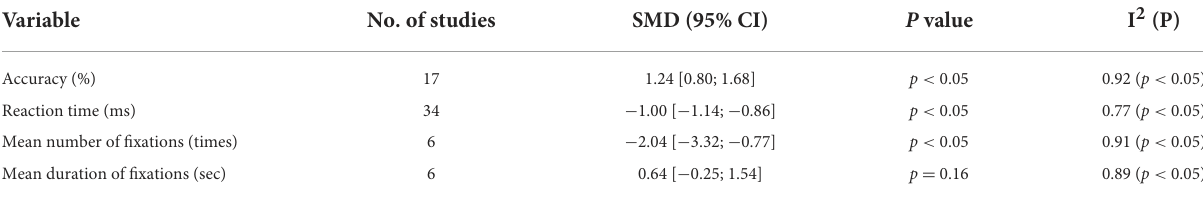
TABLE 1 Pooled estimates of standardized mean differences between the expert and non-expert